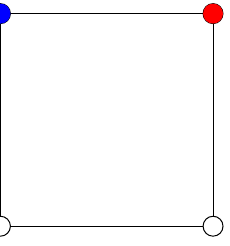
Figure 2. Fixing C 4 with two